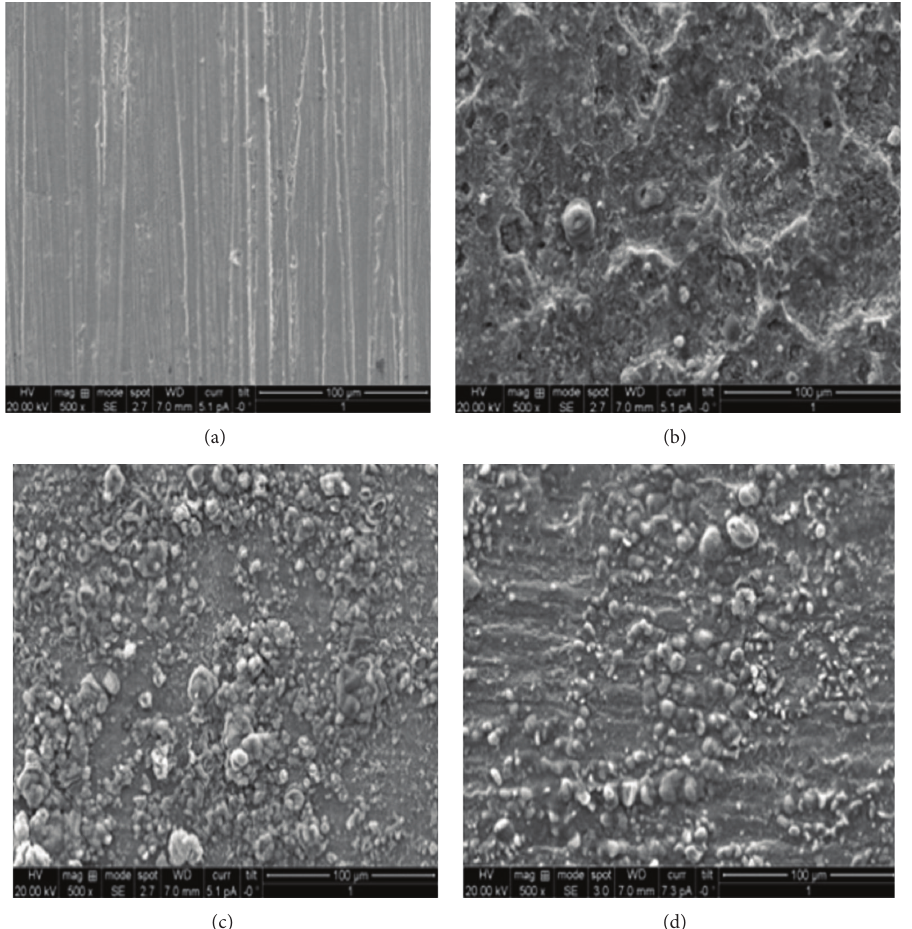
Figure 13: SEM images of (a) polished MS surface, (b) MS in 0.5 M HCl, (c) MS in 500 ppm INIMH, and (d) MS in